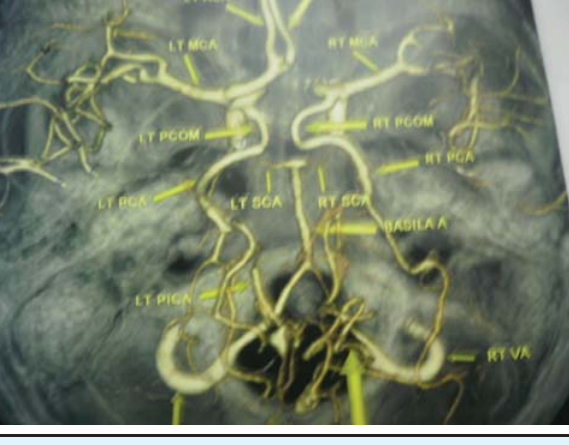
Figure 2. CT angiogram showing bilateral (mirror- telovelotonsillar segments